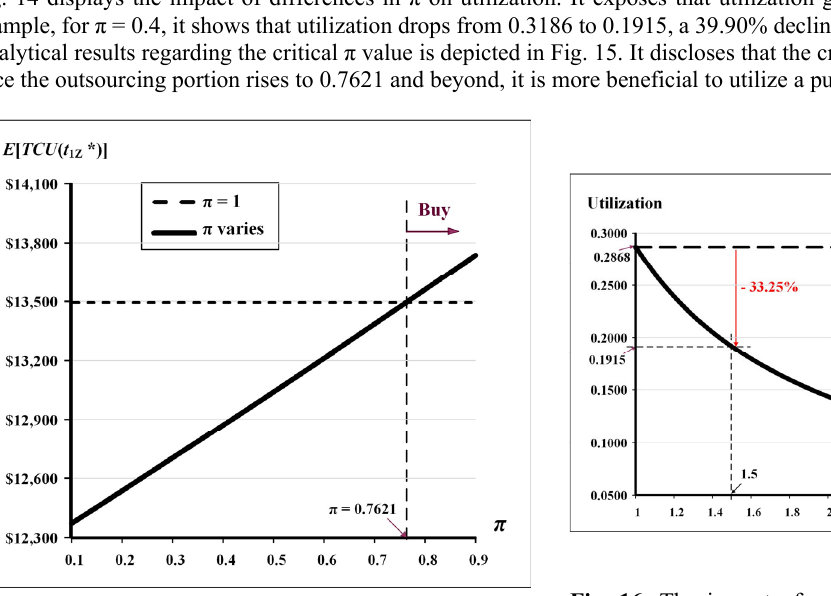
Fig. 15. A further investigative result concerning our example’s critical π value